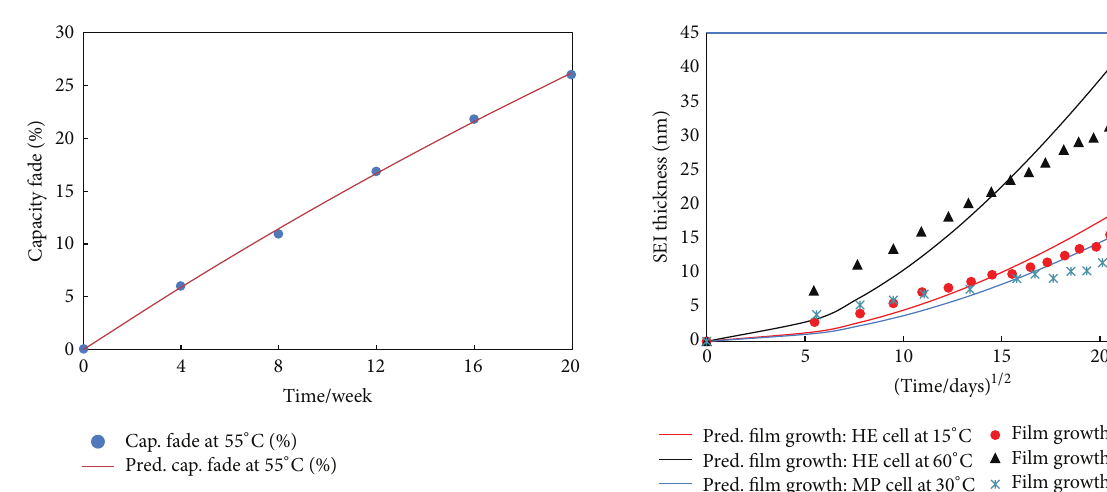
Figure 11: Estimated film thickness values from capacity fade model for HE type cell and MP type cell in comparison with experimental